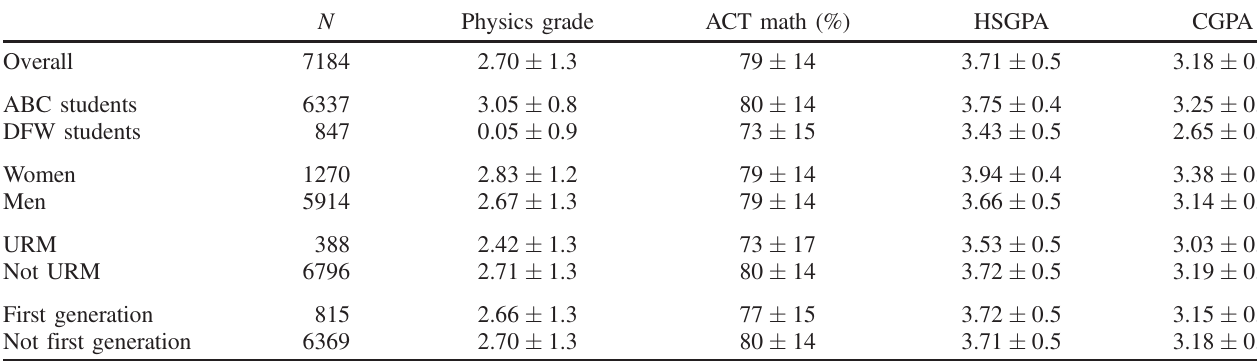
TABLE III. Descriptive statistics for sample 1. All values are the mean (cid:2) the standard deviation.